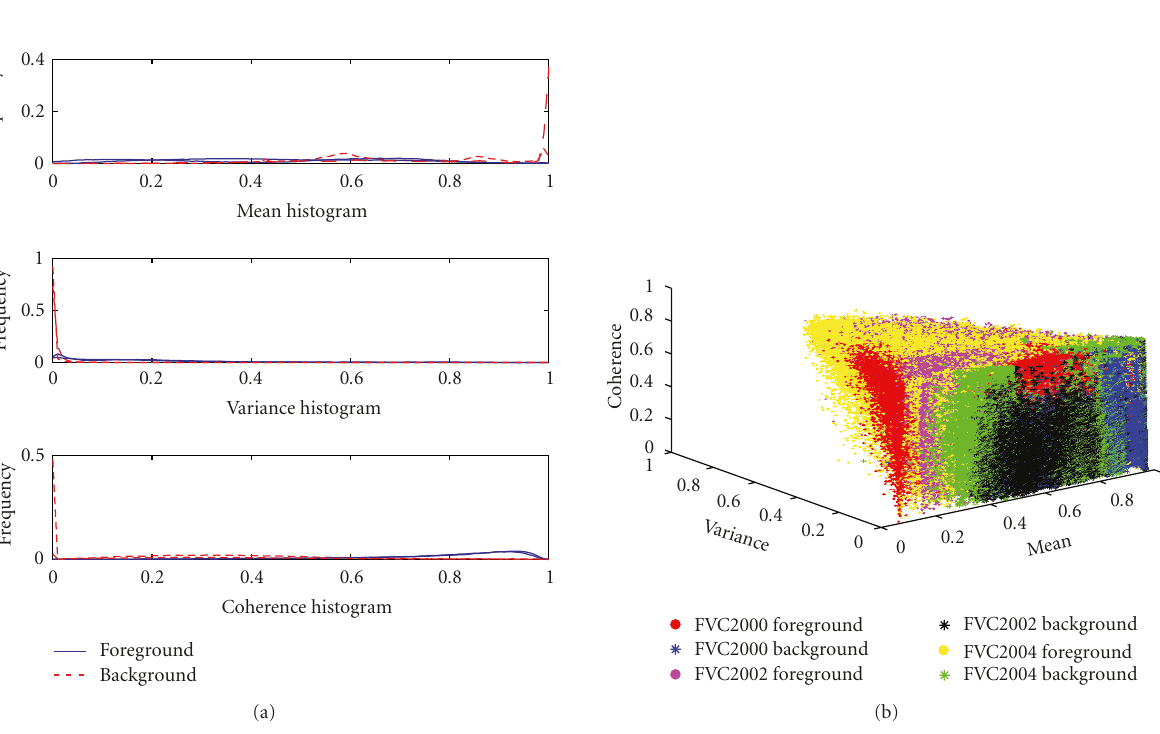
Figure 5: CMV histograms and distribution of all the 90